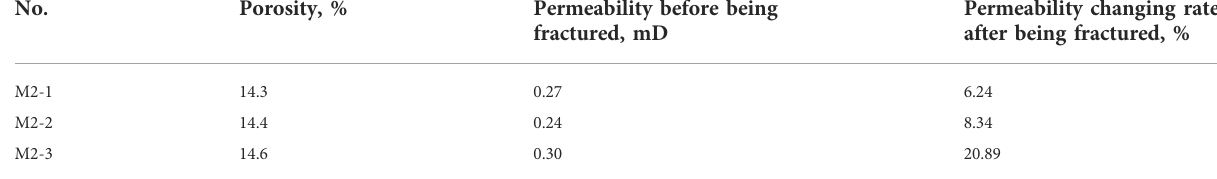
TABLE 2 Fracture generation curves in slit cores.